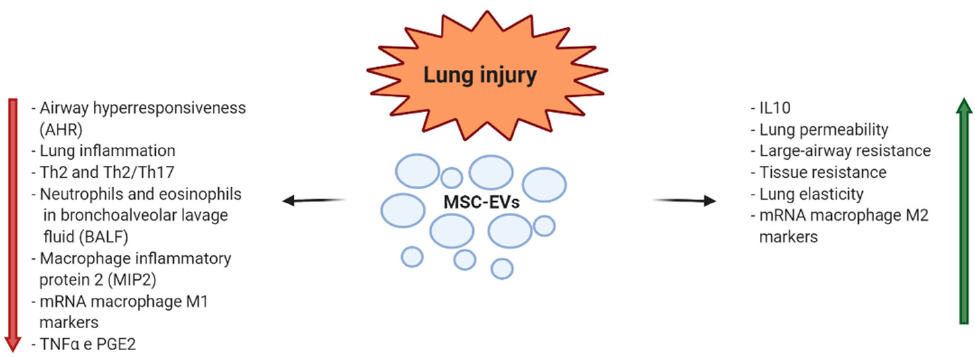
Figure 3. MSC-EV mechanisms of action in modulation of lung diseases.